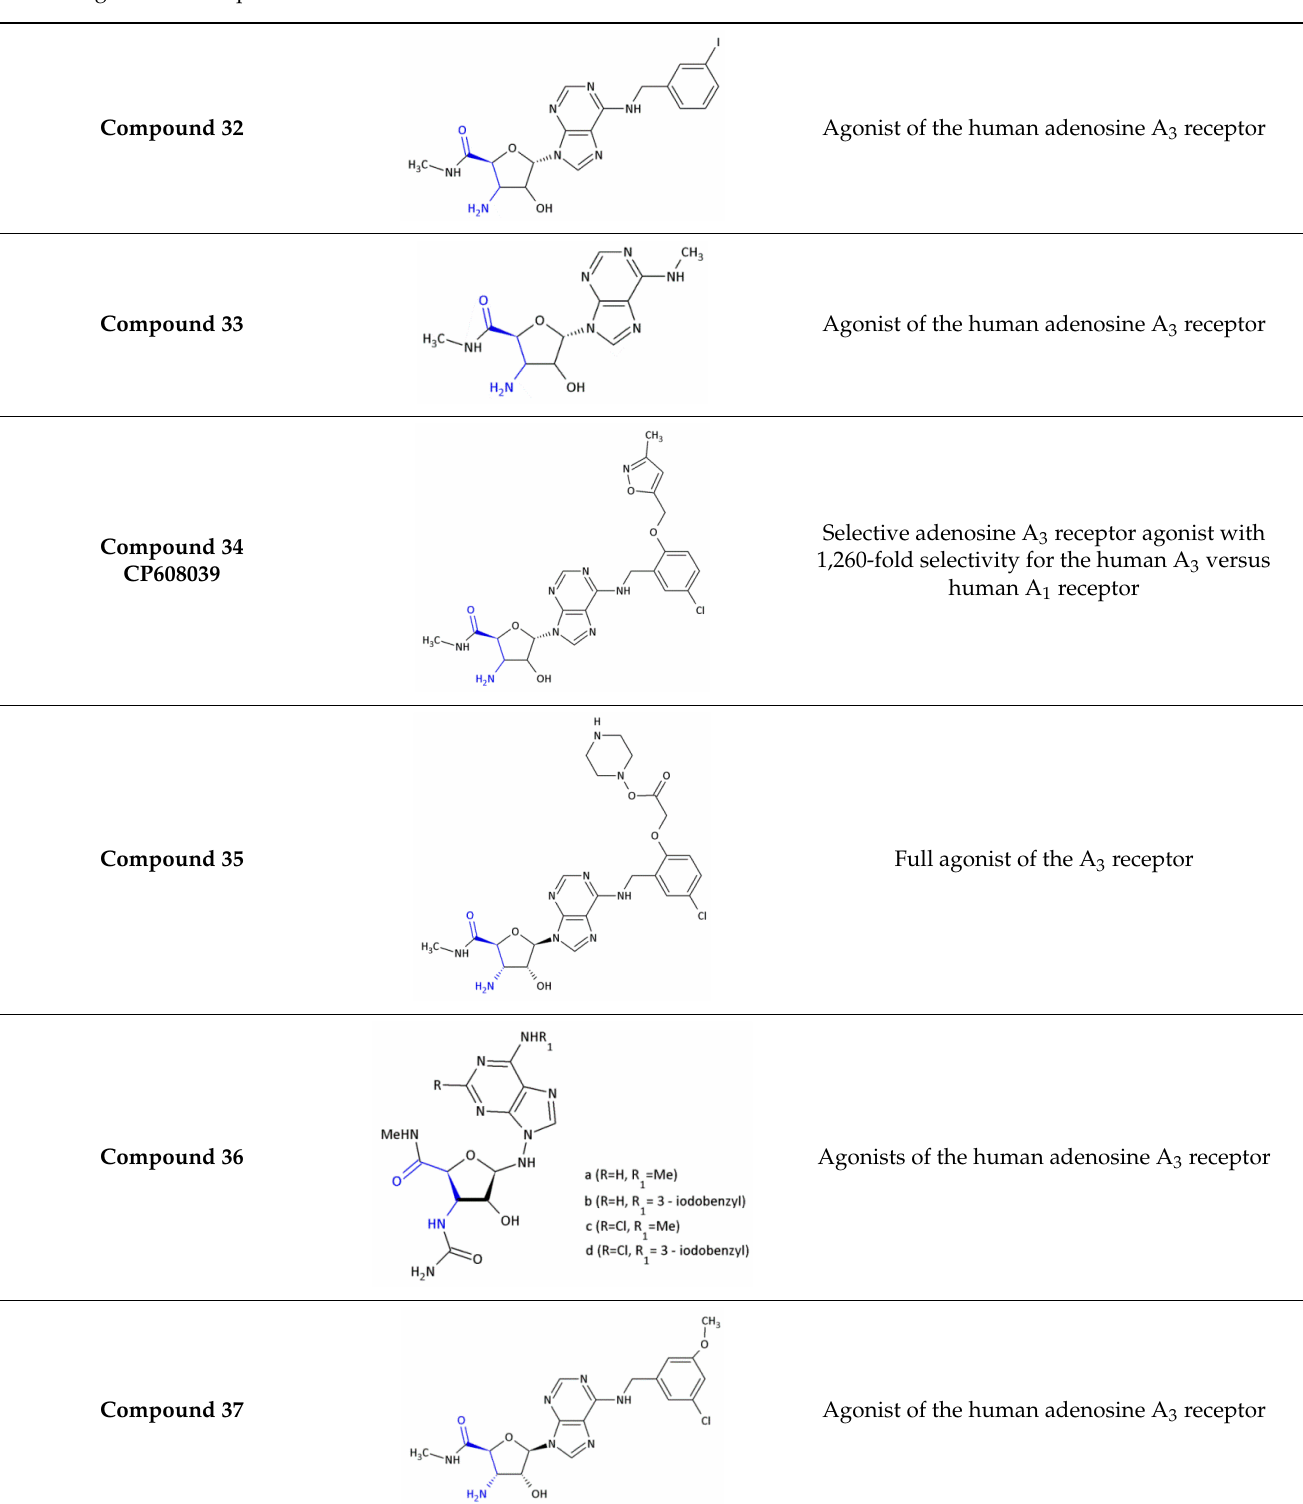
Table 5. Schematic presentation of selected β 2 and β 2,3 -amino acid heterocyclic derivatives characterized as agonists and antagonists of